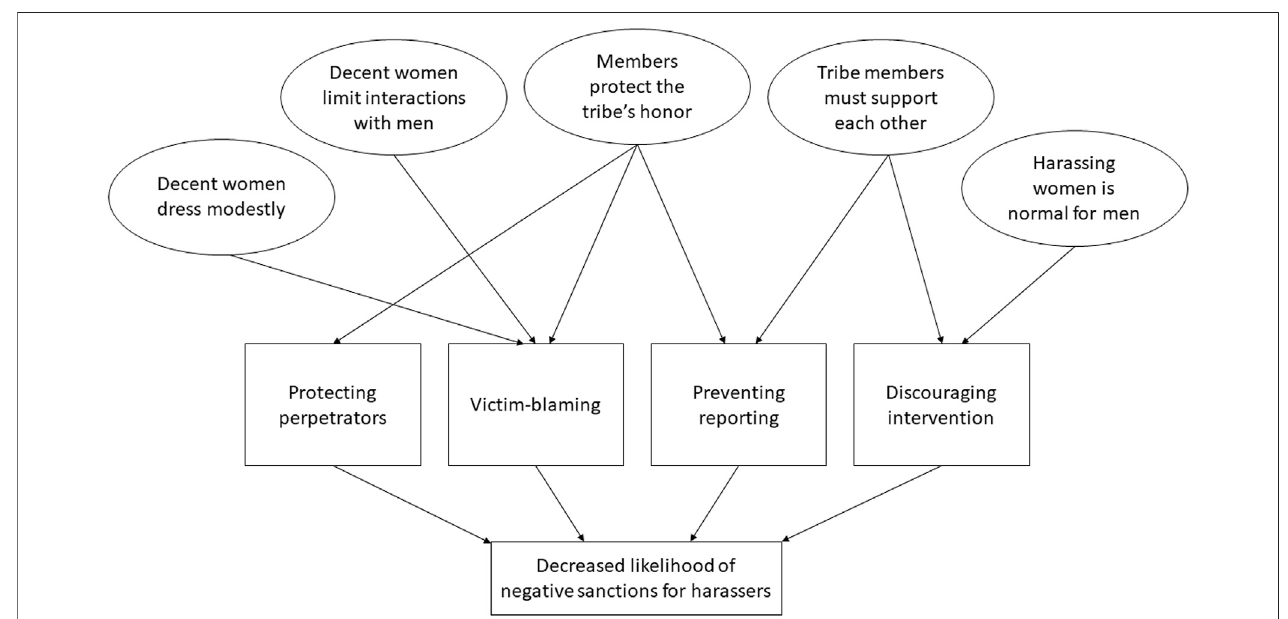
FIGURE 1 | Distal norms contributing to decreased sanctions against